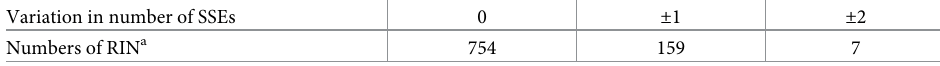
with no variation vs 78% of RIN ab ). s s